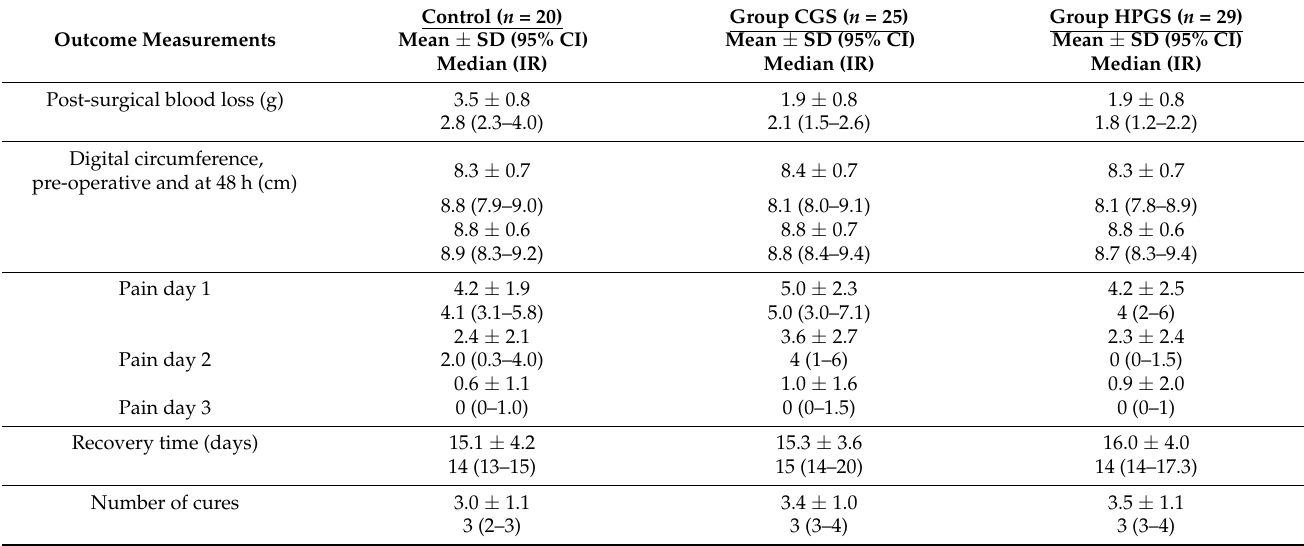
Table 2. Outcome measurements in the three treatment groups.